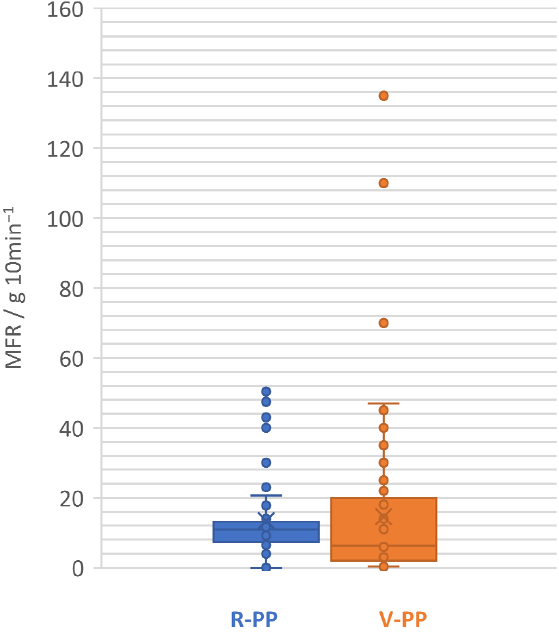
Figure 1. MFR values of recycled (R-PP) and virgin polypropylene (V-PP) at 230 °C and with 2.16 kg; for data, see Table S2.